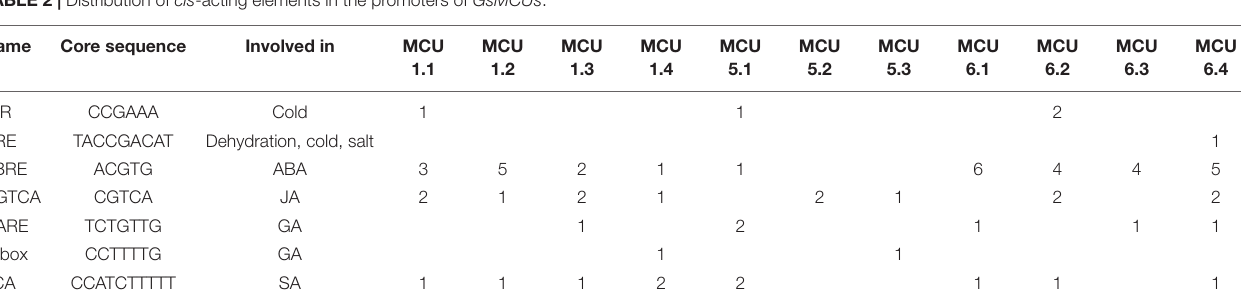
FIGURE 8 | Expression analyses of wild soybean MCU family genes under NaHCO 3 stress. For NaHCO 3 stress, the 21-day-old wild soybean seedlings were treated with 50 mM NaHCO 3 for 0, 1, 3, and 6 h. GlysoPI483463.12G046600 was used as an internal reference. The mean values ( ± SE) from three fully independent biological repeats and two technical repeats are shown. Asterisks indicate significant differences ( ∗ p < 0.05, ∗∗ p < 0.01, ∗∗∗ p < 0.001 by Student’s t -test). TABLE 2 | Distribution of cis -acting elements in the promoters of GsMCUs